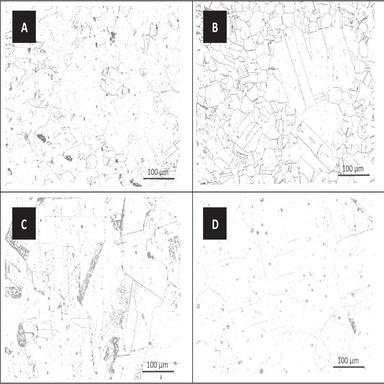
Optical micrographs of four recrystallised samples at 1005°C. A. Longitudinal sample a1a10L, B. Traversal sample a1a10T, C. Longitudinal sample a4a10L, D. Traversal sample a4a10T. Conditions and d¯ ssdata see 2.